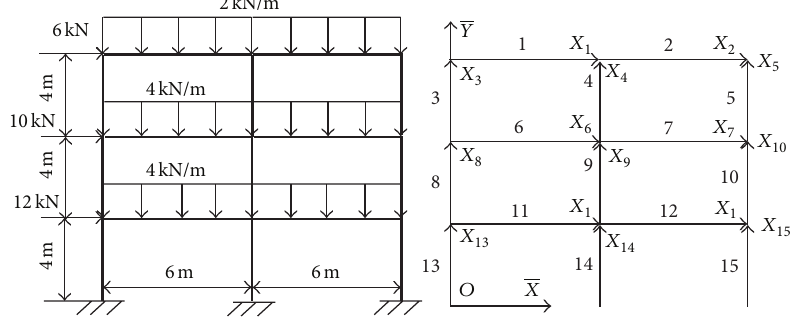
Figure 15: Coordinates, material parameters, and load parameters of plane rigid